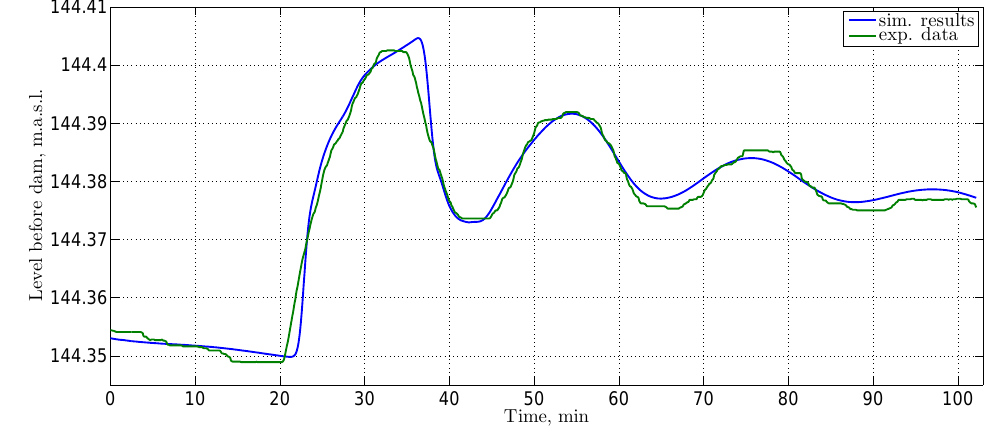
Figure 16: The results of the least squares model